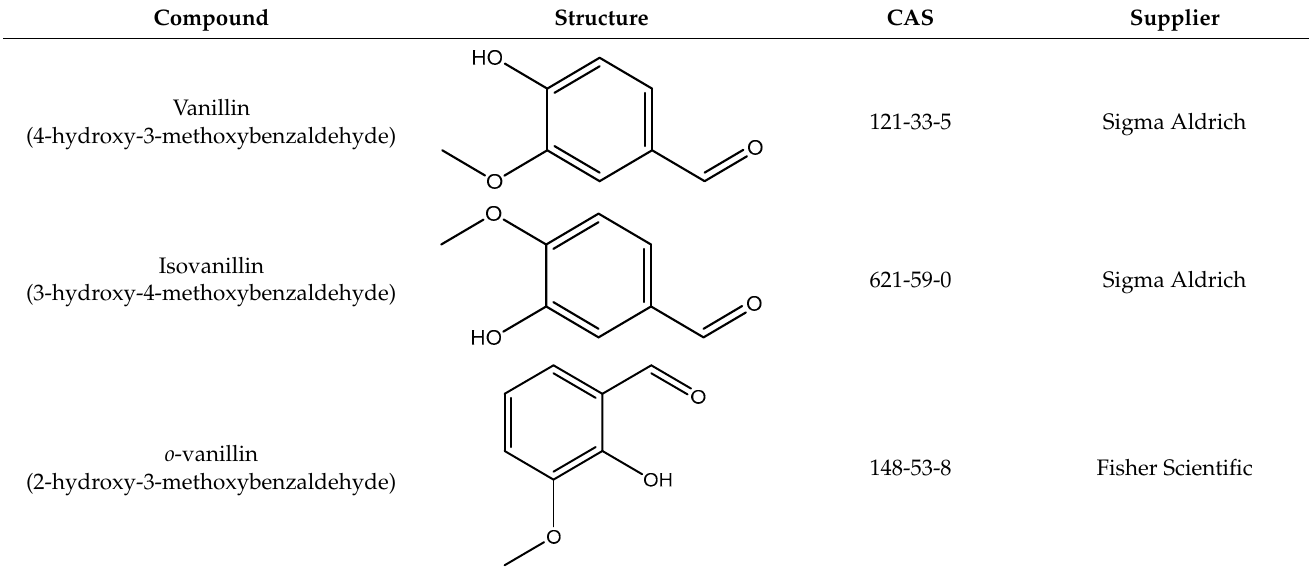
Table 1. Benzaldehydes measured with the Knudsen effusion mass spectrometry (KEMS). Compounds above the dashed line are capable of H-Bonding in the pure component and those below cannot.